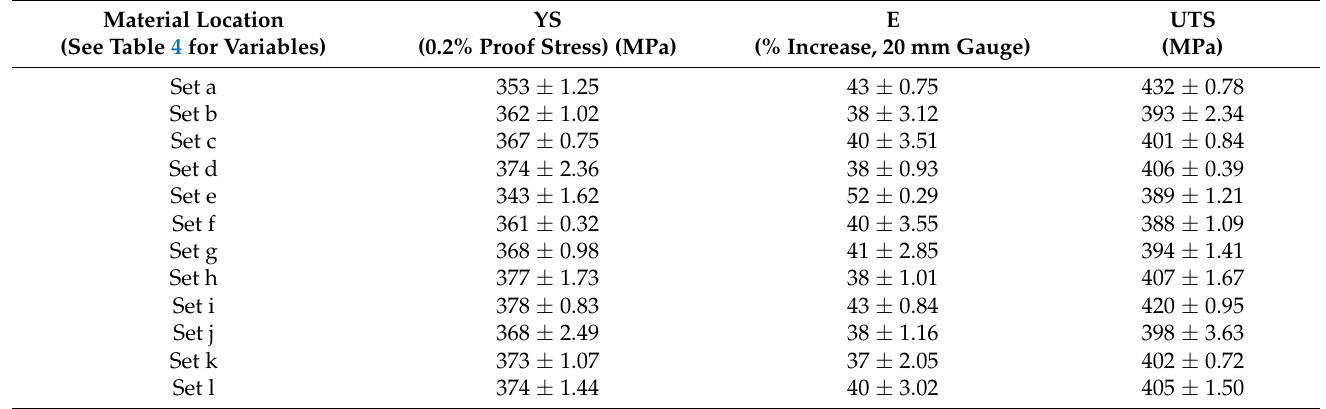
Table 6. Material properties for CP-Ti50A sheet as-received and with LMD added thickness of variable